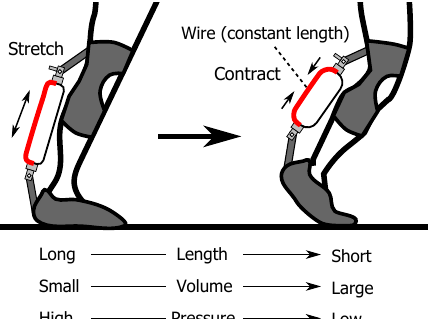
Figure 6. Deformation of CB PARM in pre-swing phase (( left ) long length state, ( right ) short length state). The red line represents a wire whose length is constant. At the start of the pre-swing phase, the PARM is stretched and its length is long. After that, the stretched PARM contracts in a short time, and its length and pressure become short and